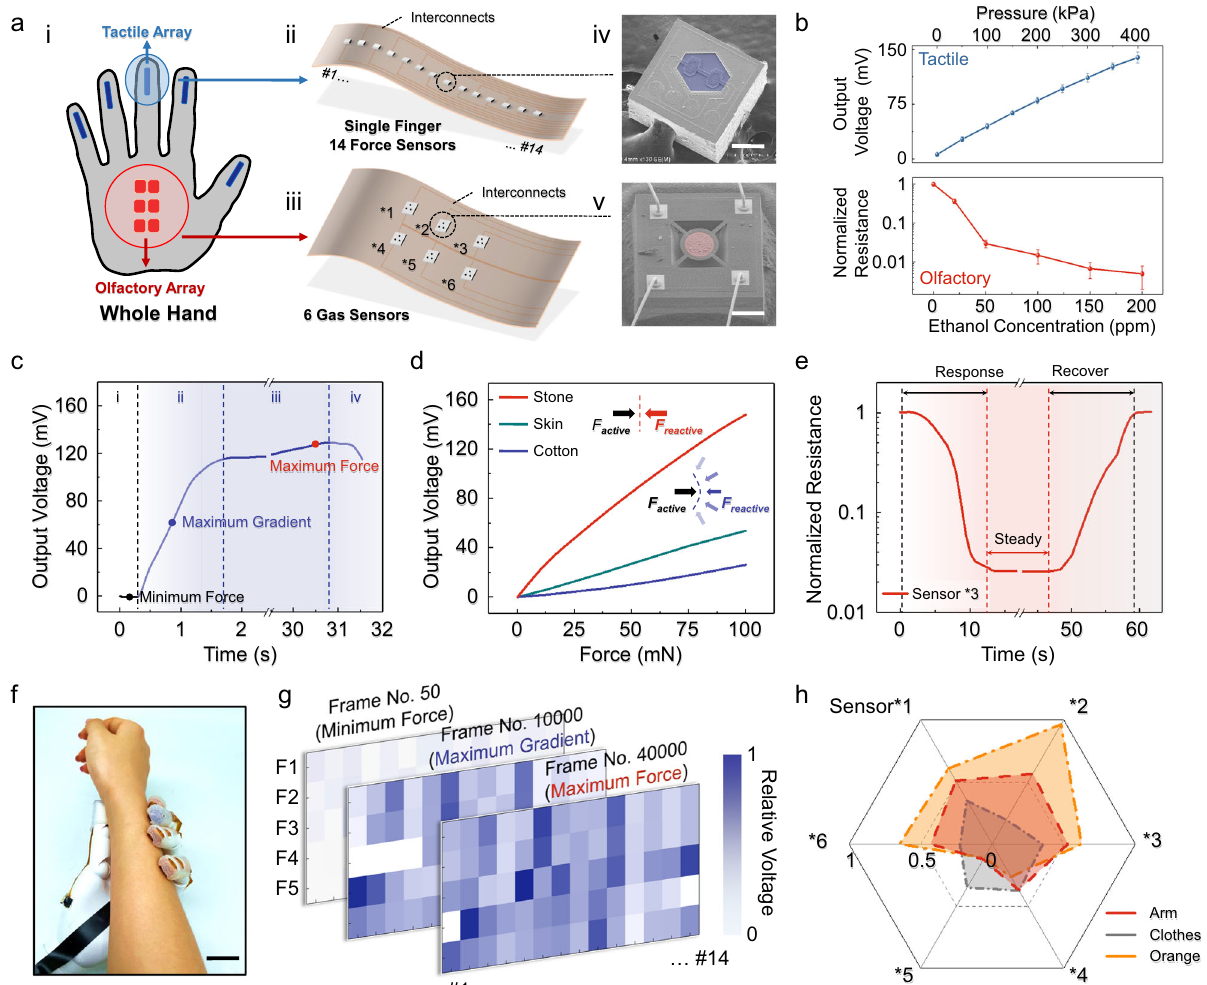
Fig. 2 Characterization of tactile and olfactory sensing array. a The design of the array architecture (i) shows the location of the 14 force sensors on each fi ngertip (ii), along with the location of the six gas sensors on the palm (iii). The Si-based force (iv) and gas (v) sensors are fabricated using microelectromechanical systems techniques and integrated on fl exible printed circuits. Blue area: force-sensitive area (single-crystalline silicon beam) with scale bar of 200 μ m. Red area: area modi fi ed by gas-sensitive material with scale bar of 400 μ m. b The sensitivity of the force and gas sensors. n = 12 for each group. The error bars denote standard deviations of the mean. Top: the output voltage response of the force sensor under gradient pressure loading. Bottom: The normalized resistance response of the gas sensor in the continuously increasing ethanol gas concentration. c In a typical touching process, the fi ngers increasingly get closer to the object until the point of contact (i. reach phase) and experiences a sudden rise in tactile forces as the object is touched (ii. load phase). Then the hand would hold the object for a certain time (iii. hold phase) and at last release the object (iv. release phase). d Response curve of the force sensor during the process of contacting three different objects. When the same force is applied to the objects by the mechanical hand, the deformation degree of the objects varies according to their different elasticity modulus, changing the local contact area and consequent reactive pressure. e The normalized resistance response curve of the gas sensor during the process of contact and separation from the detected gas fl ow. f Photograph of the mechanical hand touching a human arm, scale bar: 2 cm. g The tactile mappings at three different feature points in ( c ). Each contains 70 pixels with 14 pixels for each fi ngertip. h The hexagonal olfactory mappings of three different objects including an arm, worn clothes, and an